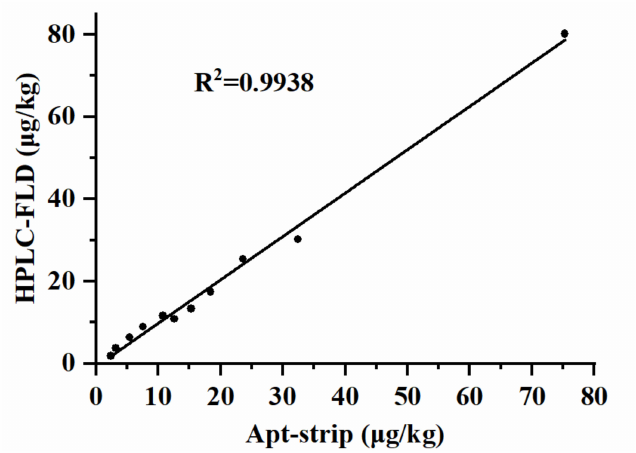
Figure 5. Correlation between Apt-strip and HPLC-FLD for the quantification of AFB 1 in real samples ( n =